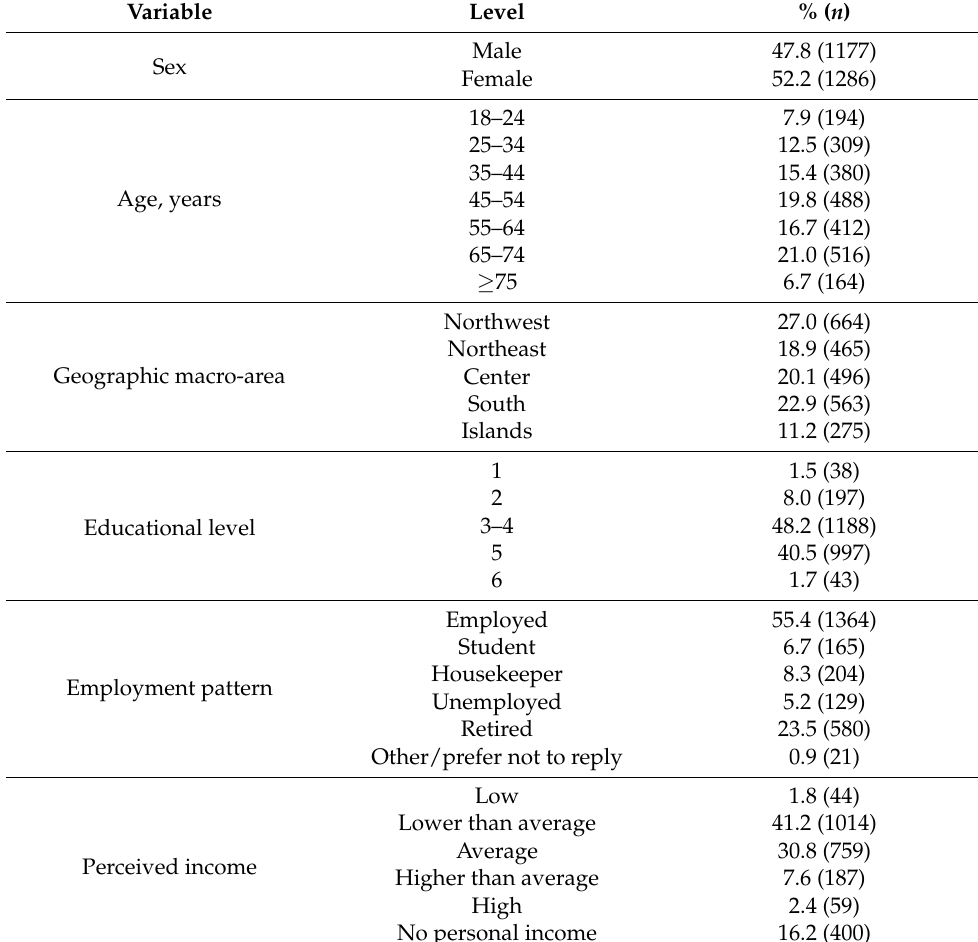
Table 1. Socio-economic characteristics of the study participants ( n =